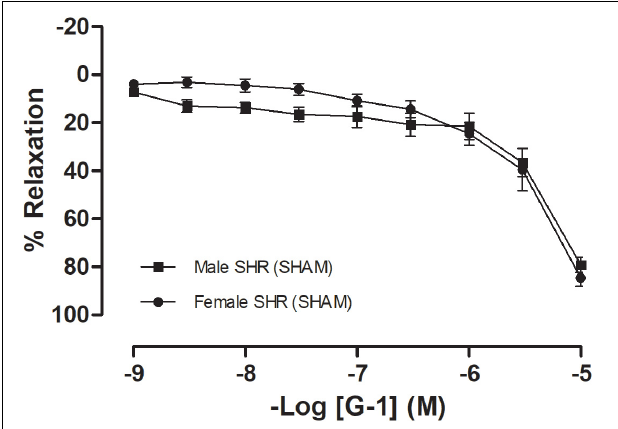
FIGURE 1 | Concentration-response curves for the selective GPER agonist G-1 (1 nM-10 µ M) in mesenteric resistance arteries are similar in both sexes. Female SHR ( n = 10) are represented by circles and male SHR ( n = 13) by squares. Reactivity protocols were performed in females during the diestrus cycle. Values are expressed as mean ± SEM. The curve was analyzed point-by-point through two-way ANOVA, followed by the Sidak post hoc test.